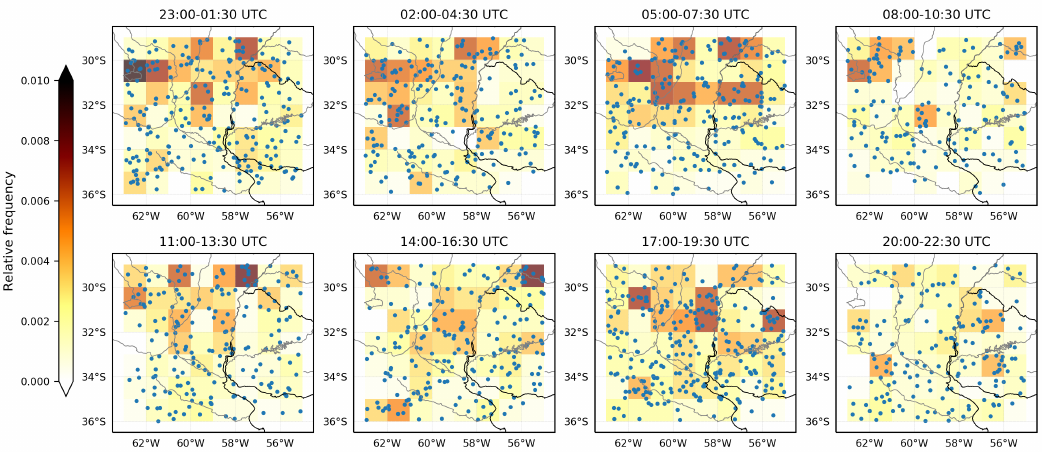
Figure 14. Same as Figure 11, but for the eastern central Argentina and Uruguay (PS) region. CI sample size: